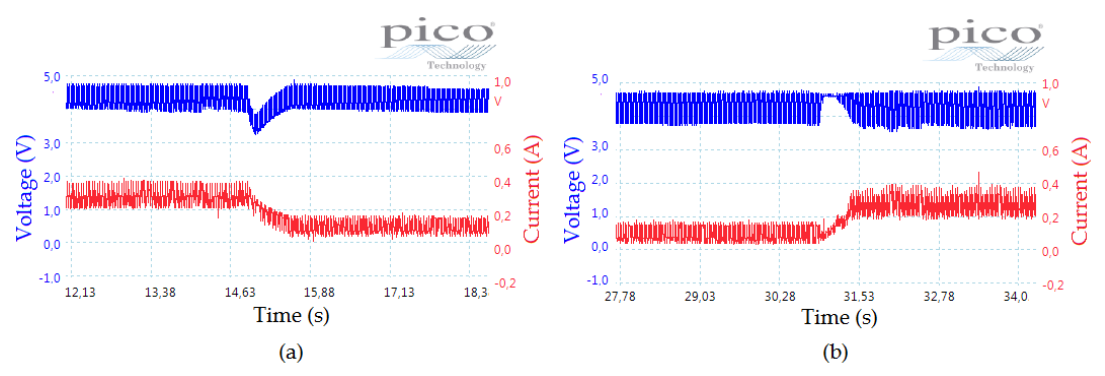
Figure 18. PV voltage and current time evolution by employing the hysteresis method (a zoomed in version).